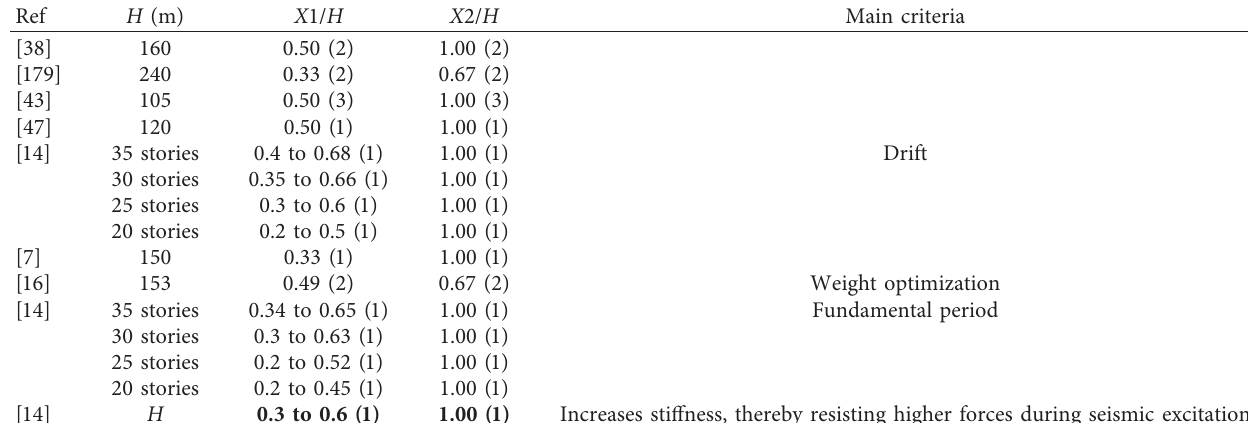
Table 6: Steel braced core walls with two steel outrigger trusses.